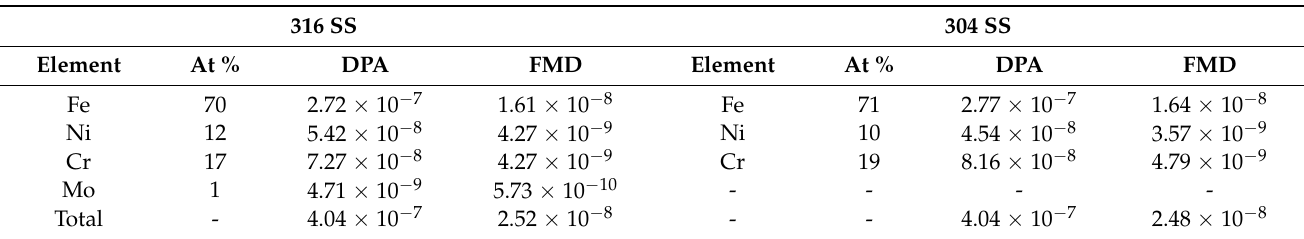
Table 2. Atomic displacement per atom (DPA) and freely-migrating point defect (FMD) production rates (atom fraction · s − 1 ) for 316 and 304 Stainless Steel in EBR-II. 316 SS